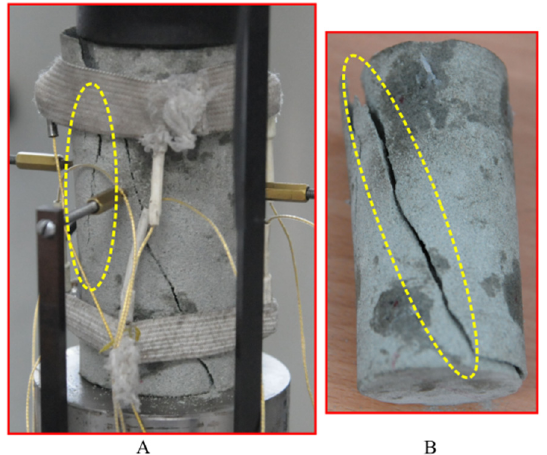
Figure 15. Contour diagram of strength failure of graded incremental loading creep test.